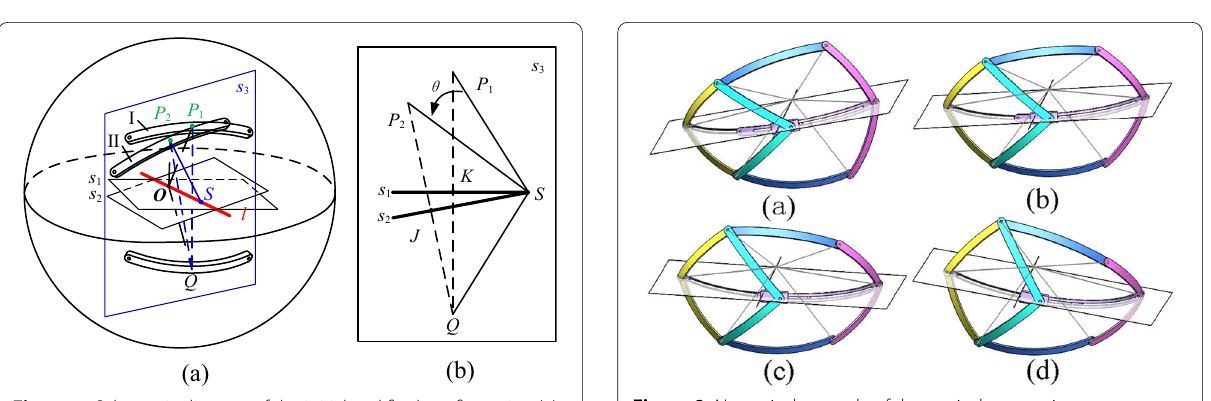
Figure 7 Schematic diagram of the initial and final configuration ( a ) and front view of plane s 3 ( b )